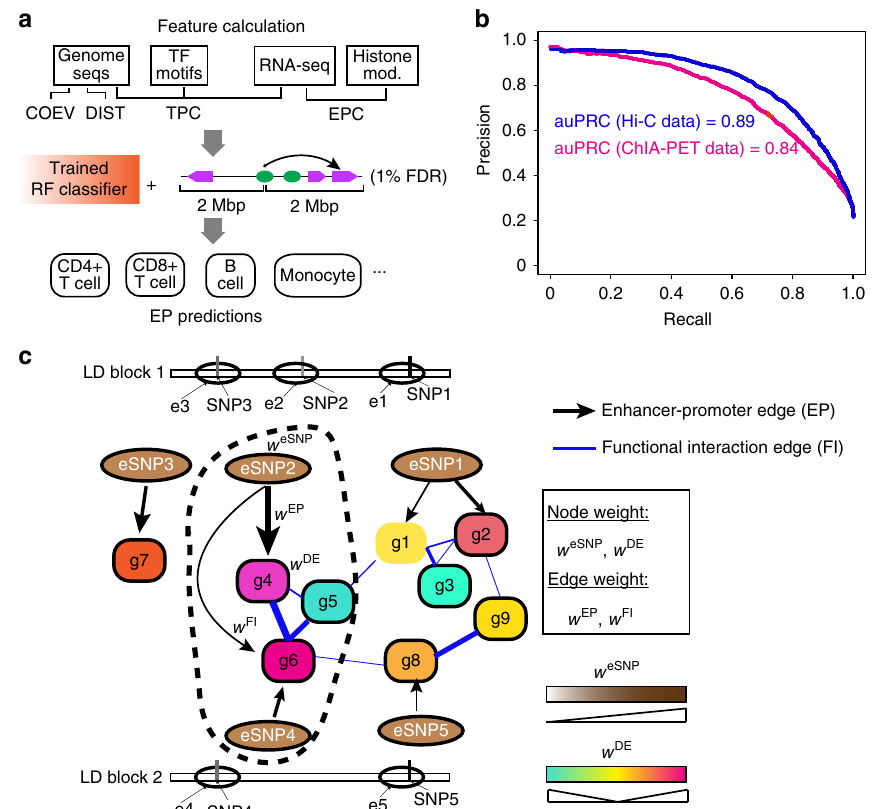
Fig. 1 Construction of weighted and disease-relevant gene regulatory network for prioritizing risk SNPs located in regulatory DNA sequences. a The IM-PET algorithm for predicting enhancer targets. Features used by the random forest (RF) classi fi er are: COEV, coevolution of enhancer and target promoter; DIST, distance constraint between enhancer and target promoter; TPC, transcription factor and target promoter correlation; EPC, enhancer and target promoter pro fi le correlation; FDR, false discovery rate. b Performance evaluation of IM-PET using Hi-C and ChIA-PET data. Sources of Hi-C and ChIA-PET data are listed in Supplementary Table 2. c Schematic for an integrated, disease-relevant gene regulatory network. The network involves SNP-containing enhancers and their target genes and functional interactions among the target genes. Such a network is constructed by integrating transcriptomic and epigenomic data on cells/tissues relevant to the disease under study. The encircled subnetwork represents pathways targeted by a candidate risk eSNP. LD, linkage disequilibrium; e, enhancer; g, gene; EP, enhancer − promoter interaction; FI, functional gene interaction; eSNP, enhancer SNP; W eSNP , weights for eSNPs; W DE , weights for differential gene expression; W EP , weights for EP edges; W FI , weights for FI